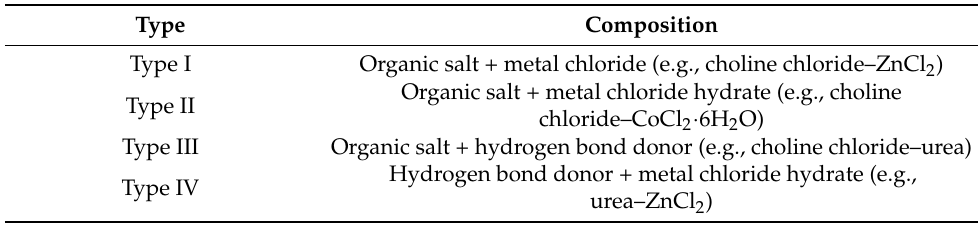
Table 1. Classification and examples of deep eutectic